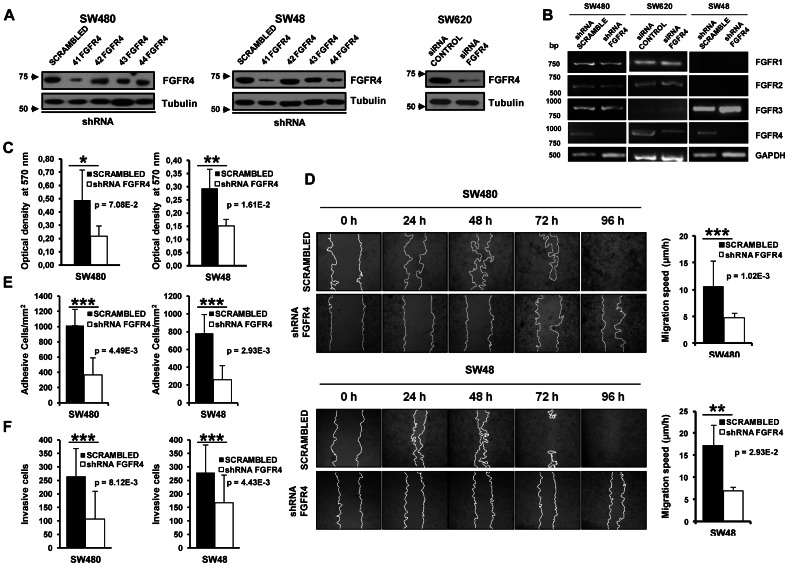
FGFR4-silencing in colorectal cancer cells decreases tumorigenic and invasive properties of colorectal cancer cells.Four shRNAs directed against different exons of FGFR4 and a scrambled shRNA were used to obtain stably transfected colorectal cancer cells after selection with puromycin. In addition, transient siRNA FGFR4-silencing was carried out in SW620 colorectal cancer cells. A. Western blot analysis of FGFR4 expression in stably transfected SW480 and SW48 cell lines, and transiently-transfected SW620 cells. Tubulin was used as loading control. B. Semi-quantitative PCR analysis of FGFR1, FGFR2, FGFR3, and FGFR4 expression using specific primers in three different cell lines. GAPDH was used as control. C. Proliferation was determined by MTT assays after 24 h of culture. Optical density was significantly decreased by FGFR4 knockdown (*, p<0.01; **, p<0.001). D. Scrambled and silenced cells were grown until confluence and their migratory capabilities were analyzed in a wound-healing assay every 24 h until confluence. Representative images of the wound-healing assay are shown. Migration speed (µm/h) of scrambled and FGFR4-silenced cells was calculated as the distance covered in 96 h. E. Cell adhesion to Matrigel of FGFR4-silenced or scrambled cells, after starving cells for 5 h in medium alone. F. SW480 and SW48 scrambled cells showed approximately 2-fold higher invasion than shRNA #41 FGFR4 stably-transfected cells. Data for all the experiments represent the mean ± SD of 3 independent experiments. p values of all the experiments are shown.